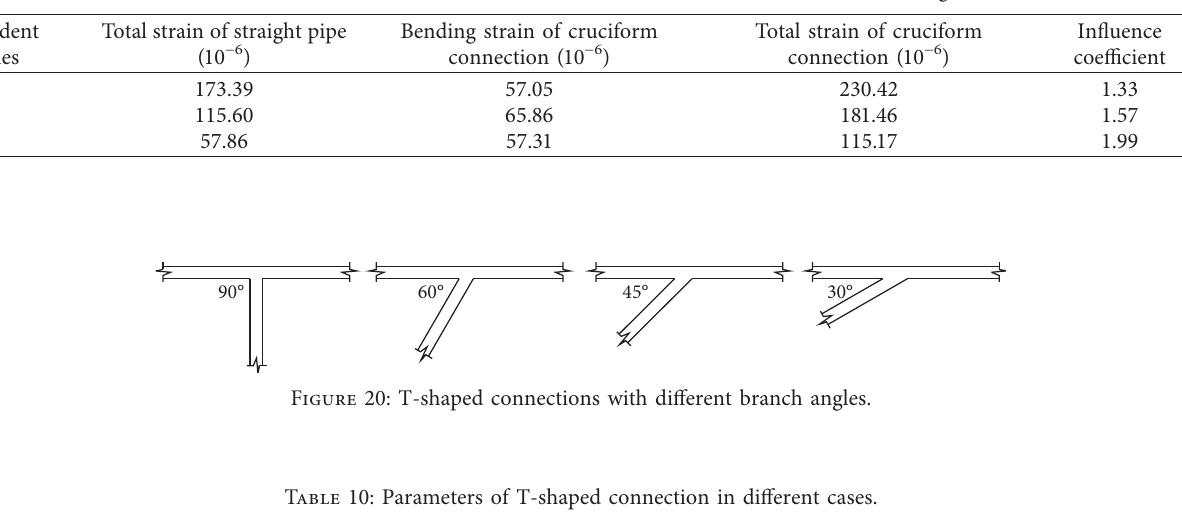
Table 9: Influence coefficients of cruciform connection with different incident angles.